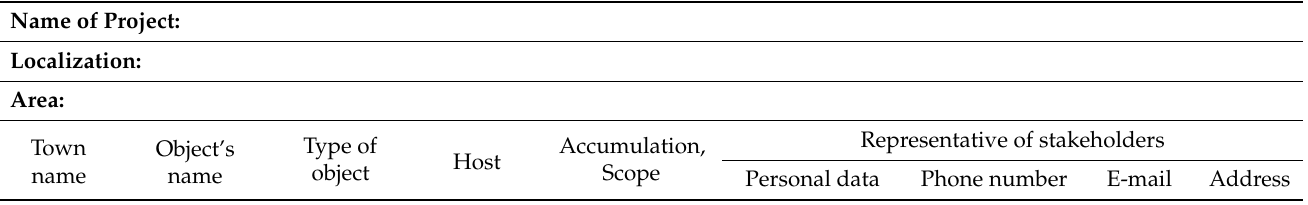
Table 1. The proposed header part of the